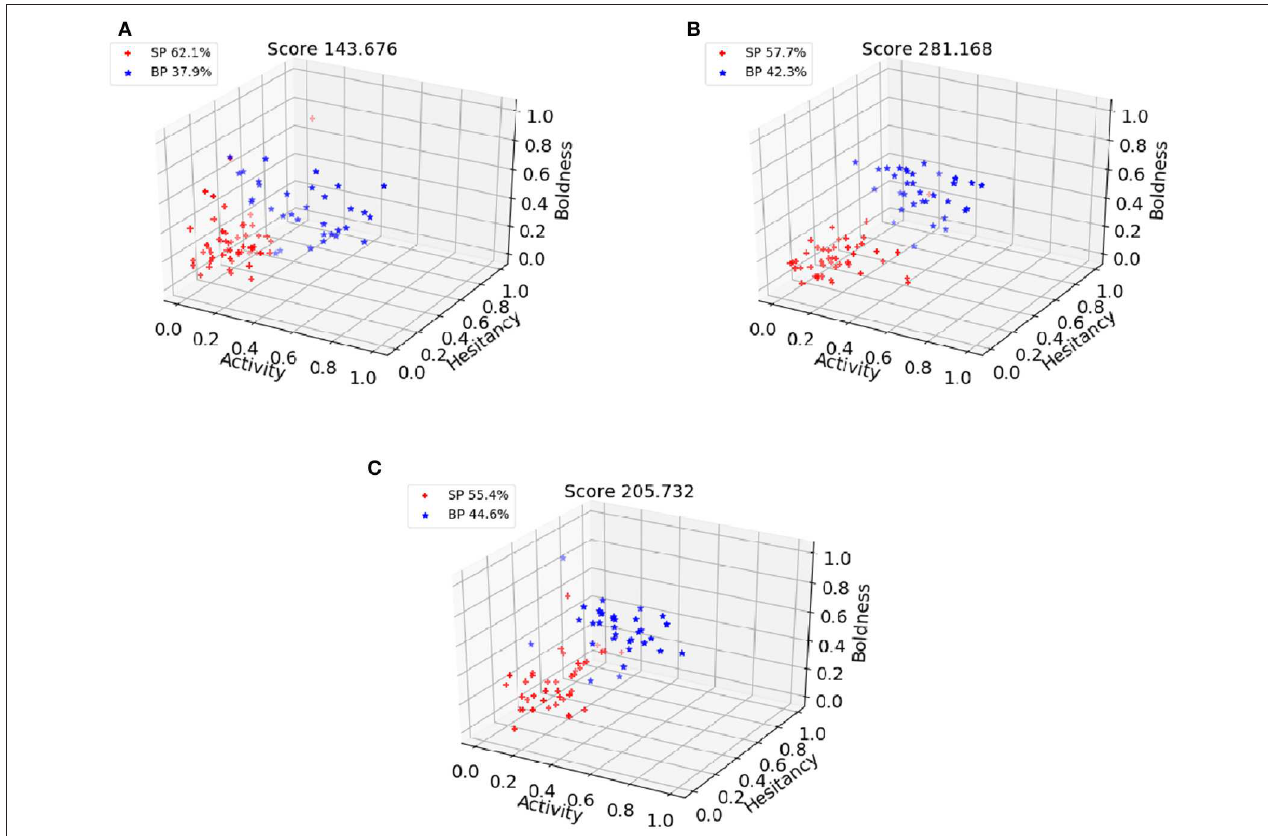
FIGURE 5 | Clustering result based on three personality characteristics. (A) Result under 0 day starvation. (B) Result under 6 days starvation. (C) Result under 12 days